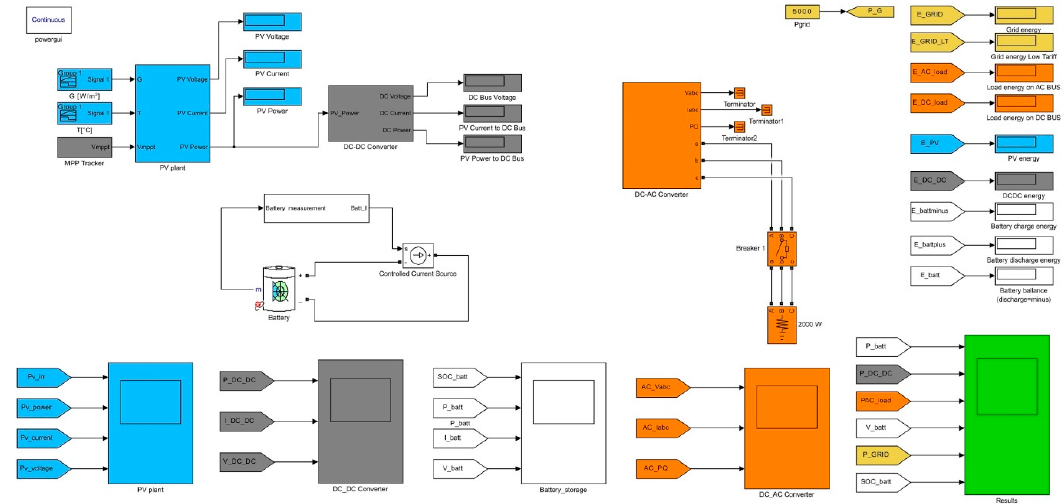
Figure 3. Implementation of a hybrid system (HS) in the Matlab Simulink programming environment.